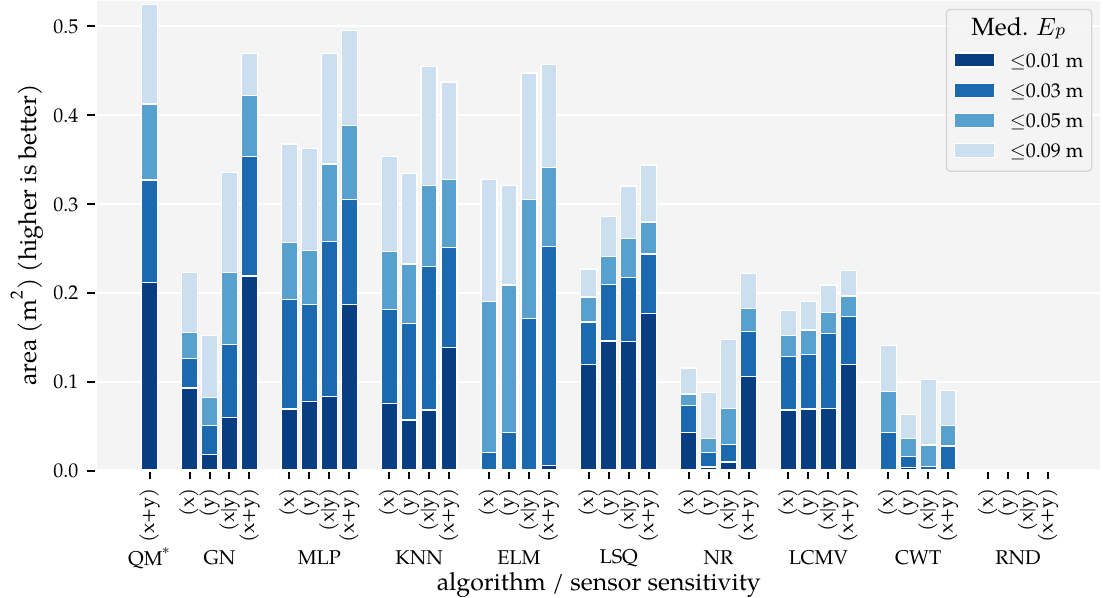
Figure 9. Total area with a median position error E p (Equation (4)) below 1cm, 3cm, 5cm, and 9cm for varying sensitivity axes of the sensors: (x + y) measured both velocity components at all sensors, (x|y) alternated measuring v x and v y for subsequent sensors, (x) measured only v x at all sensors, (y) measured only v y at all sensors. This analysis method used the D s = 0.01 training and optimisation set and the σ = 1.0 × 10 − 5 ms − 1 noise level. The median position error was computed in 2 × 2 cm 2 cells. Note, the bar for QM* is based on the D s = 0.01 condition in Analysis Method